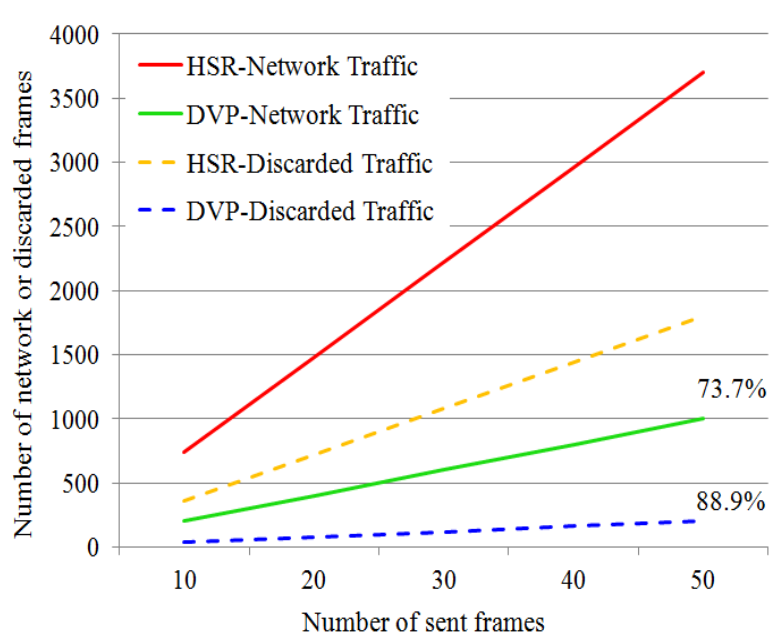
Figure 7. Network traffic and discarded traffic comparison between the HSR protocol and DVP algorithm under the first experiment: node-failure